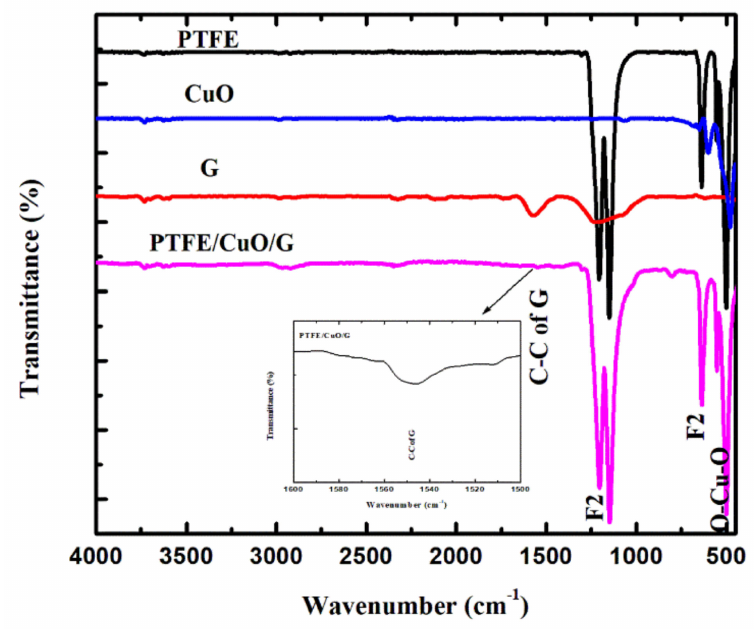
Figure 1. PTFE, CuO, G and PTFE/CuO/G transmittance ATR–FTIR